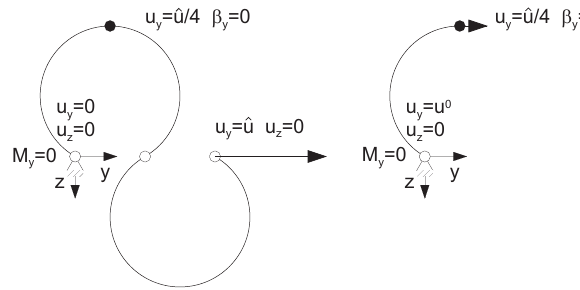
Figure 1: Geometric and mechanical unit cells